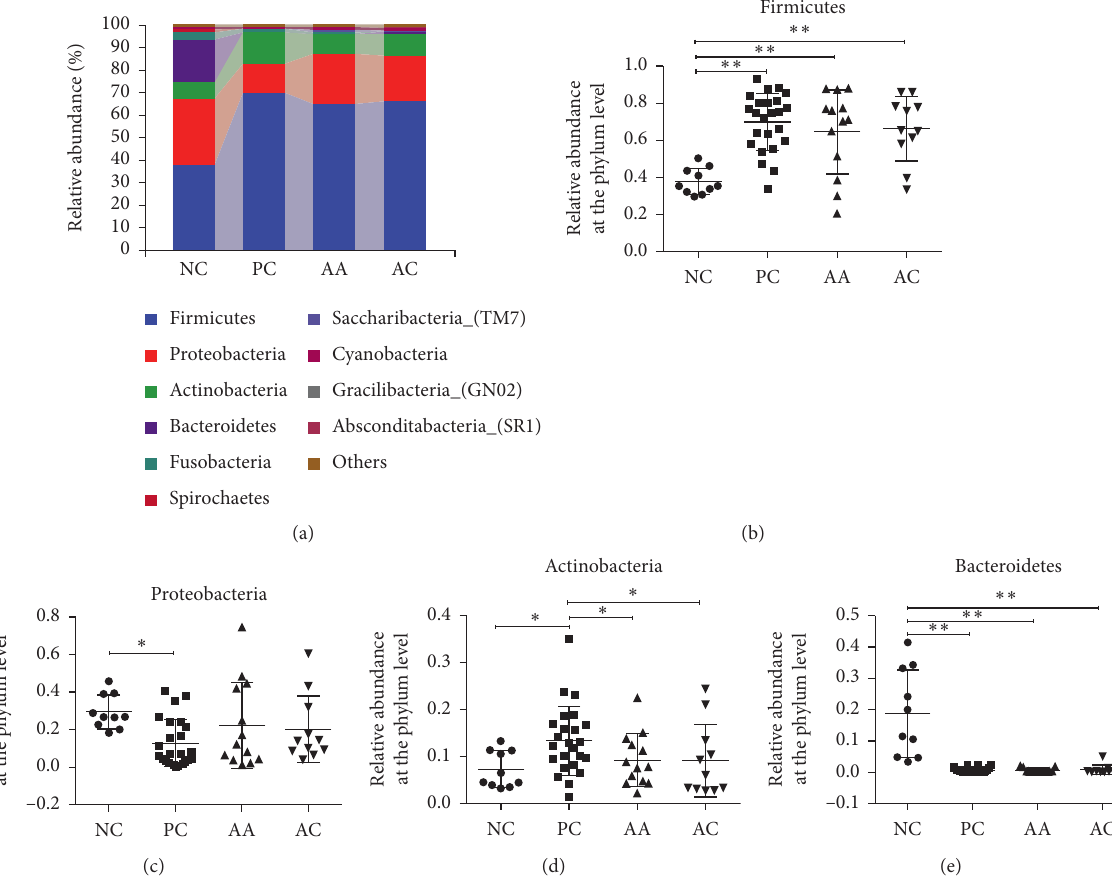
Figure 3: Evaluation of the aloe vera fermentation gel on the bacterial compositions at the phylum level. (a) The relative abundances of the top 10 bacteria at the phylum level. The relative abundances of (b) Firmicutes, (c) Proteobacteria, (d) Actinobacteria, and (e) Bacteroidetes. All data are shown as mean ± SD. Significant differences are denoted by ∗ p < 0 . 05 and ∗∗ p < 0 .